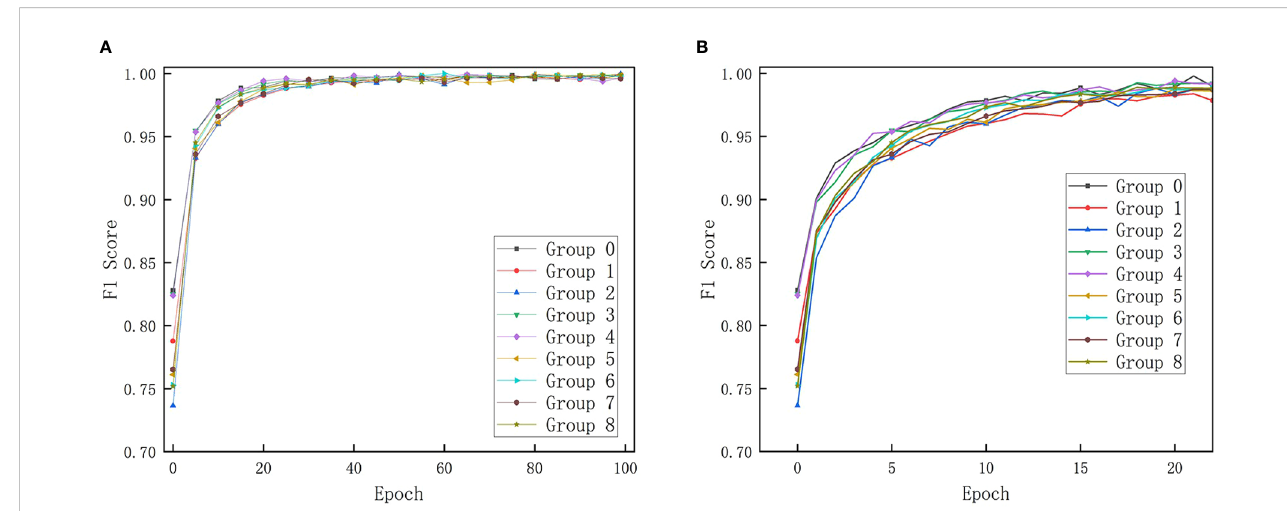
FIGURE 12 Changes in F1 score during training. Part A is the parameter change of 100 epochs, and part B is the parameter change of the fi rst 20